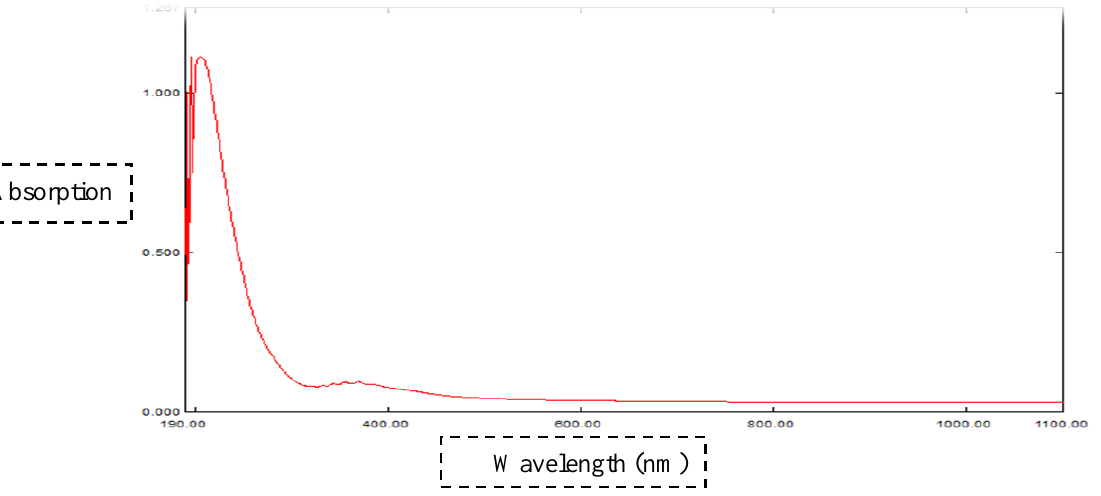
Nanoparticles Doped in PMMA 2